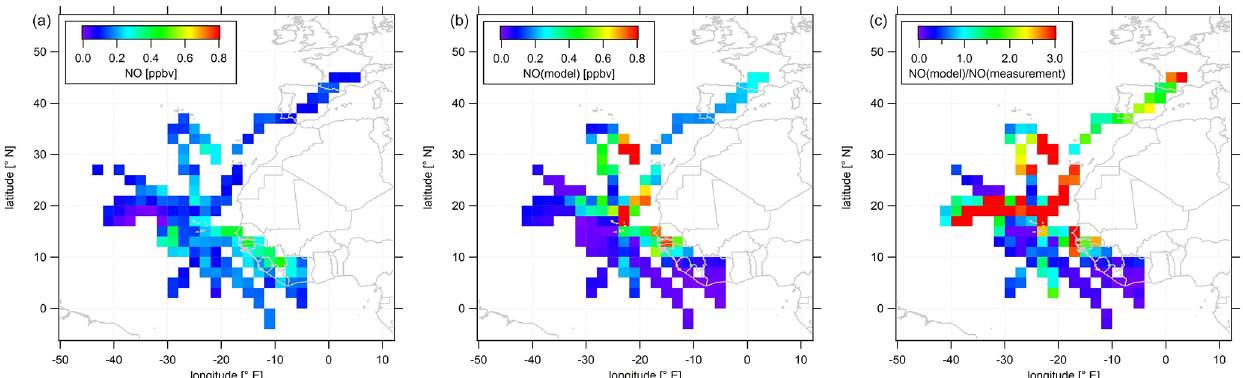
Figure 3. Color-coded spatial, tropospheric NO distributions above 12km during CAFE-Africa. Panels (a, b) show the measured and simu- lated NO concentrations, respectively. Panel (c) shows the spatial distribution of the NO ( model )/ NO ( measurement ) ratio. The figures have been filtered for stratospheric measurements by removing data points for which O 3 exceeds